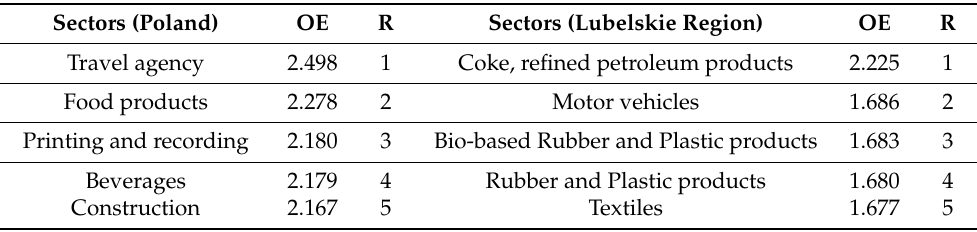
Table 6. Sectors with the highest output elasticities in Poland and the Lubelskie Region (OE = Output Elasticity; R =